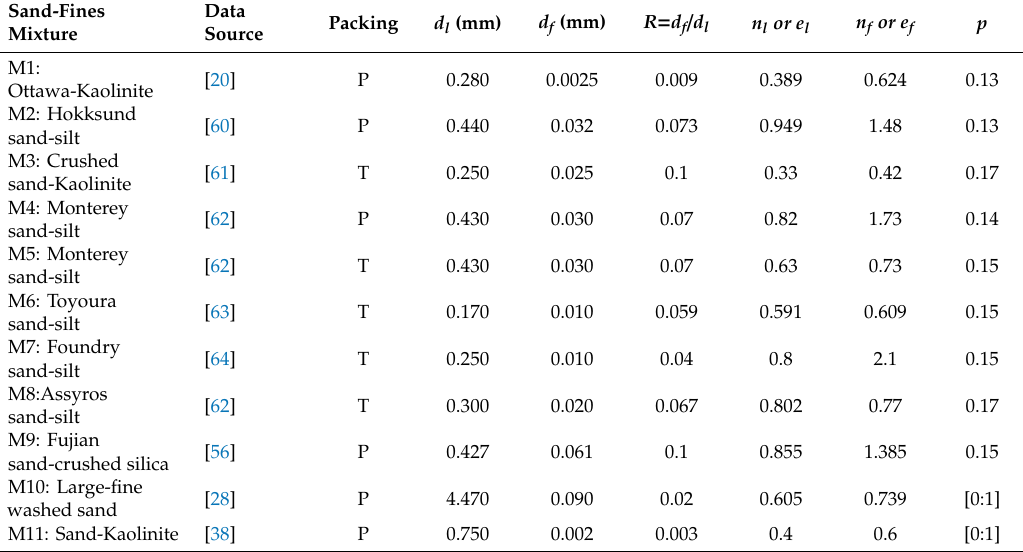
Table 1. Materials properties of selected published experimental results for sand-fines mixtures used in the model evaluation. P and T in the third column refers to the poured and tapped packing conditions